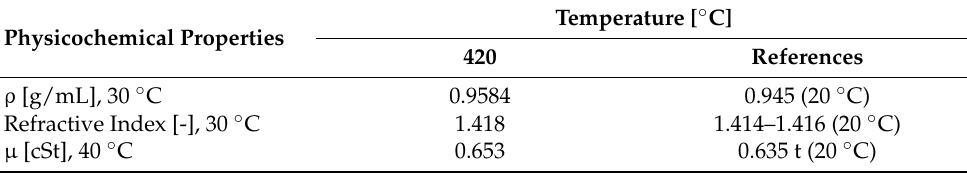
Table 5. Physicochemical properties of distillates of liquid products obtained at 420 ◦ C and atmo- spheric